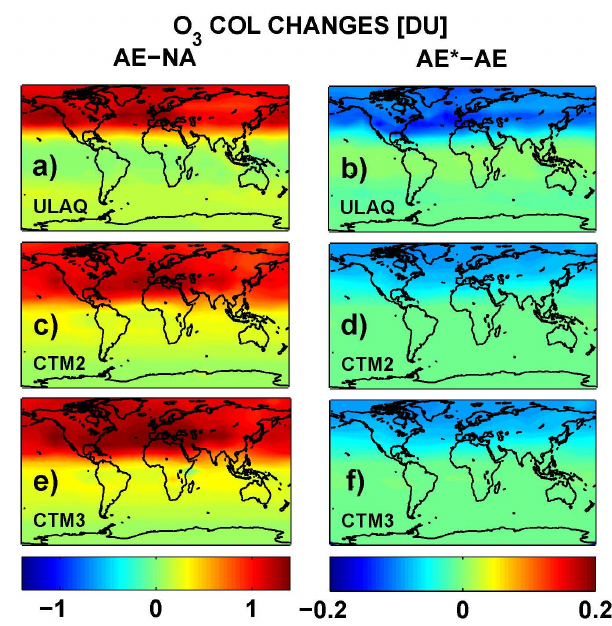
Figure 10. Results from ULAQ, CTM2 and CTM3 models for O 3 column changes (DU), from upper to lower panels, respectively. Left panels (a , c , e) are AE-NA changes; right panels (b , d , f) are AE*-AE